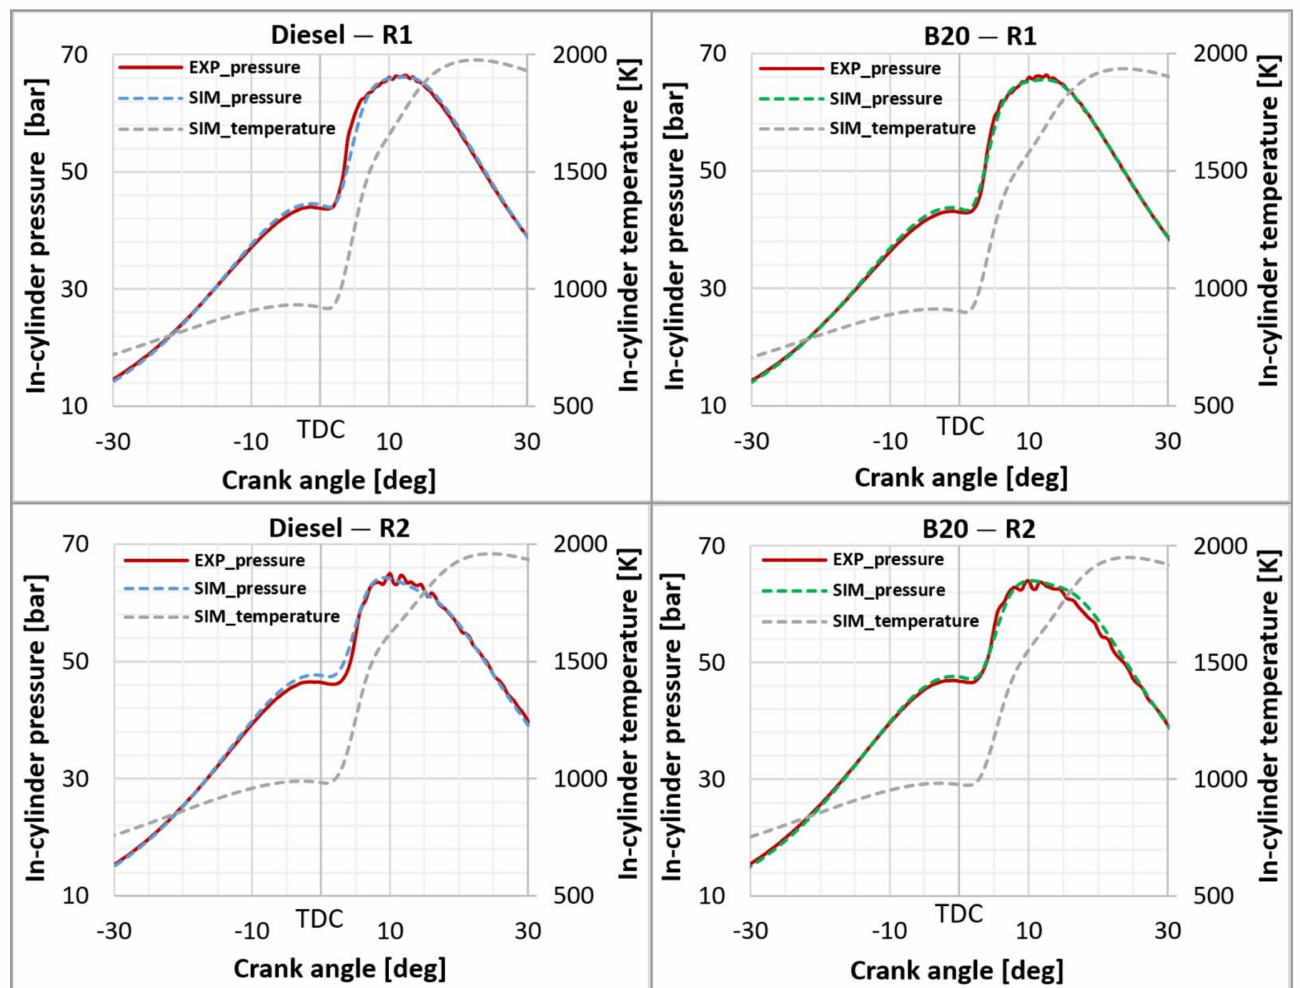
Figure 3. Pressure traces calibration and temperature variations for both engine operating conditions and tested fuels.